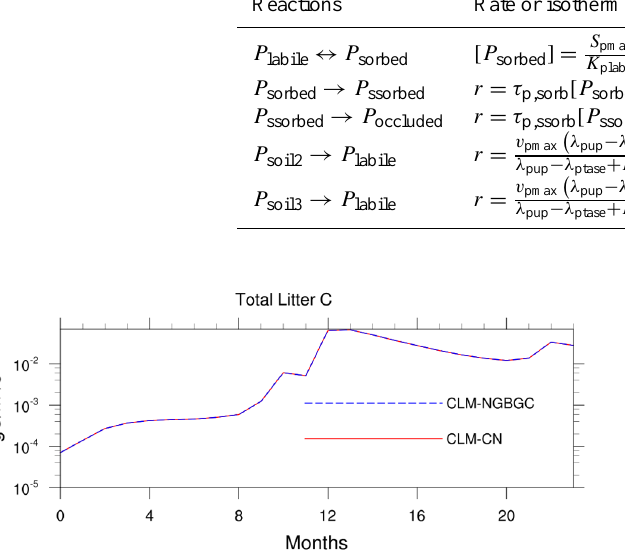
Fig. 3. Comparison of temporal change of total litter C at the Tonzi Ranch site of the original model (CLM-CN) with our new model